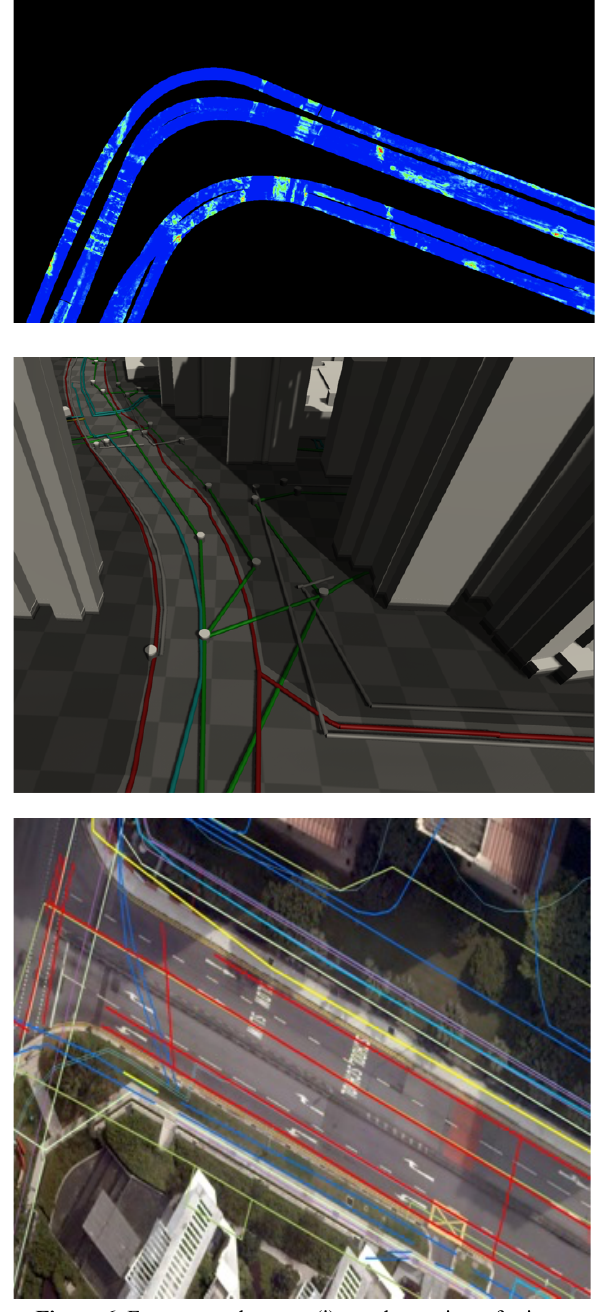
Figure 6. From top to bottom: (i) top-down view of primary GPR data, (ii) 3D render of extracted results, and (iii) comparison between utilities from GPR scans (red) and available GIS